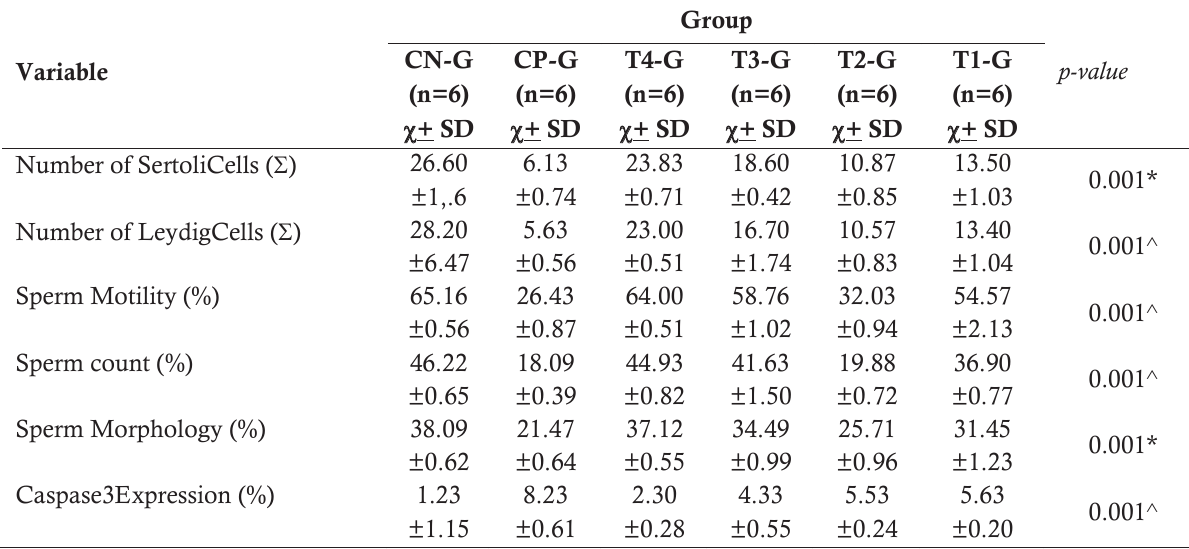
Table 1. Mean number of Sertoli and Leydig cells, sperm quality (motility, sperm count, and morphology)